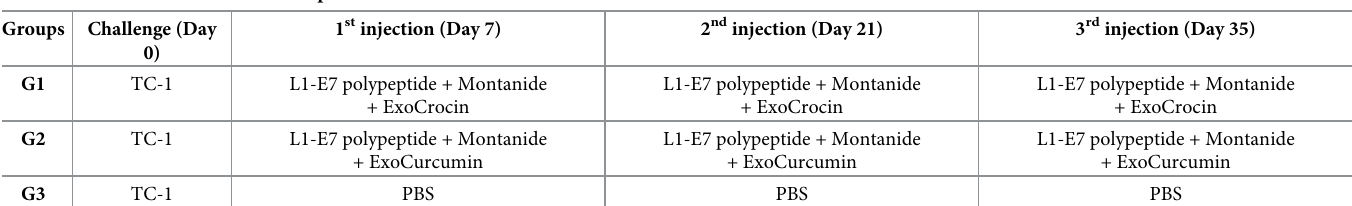
Table 2. Mice immunization for therapeutic effects. Groups Challenge (Day